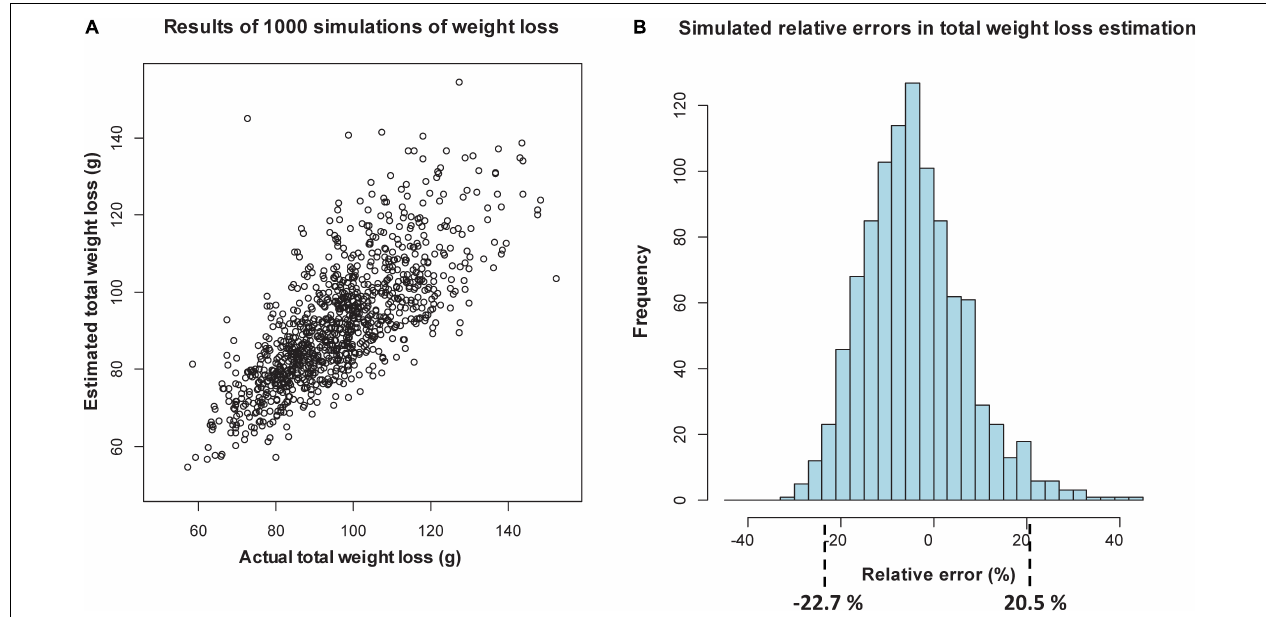
FIGURE 3 | Simulation of relative percentage errors from 1000 simulations of loss, using sectional regression models with length, width data and days from deployment as predictors: scatterplot of estimated versus actual total weight loss (A) , and histogram of the relative percentage errors, showing intervals that include 95% of the values (B) .